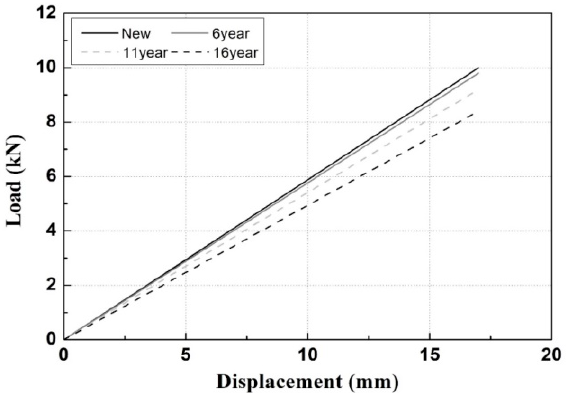
Figure 18. Load-displacement diagrams of new and used tension